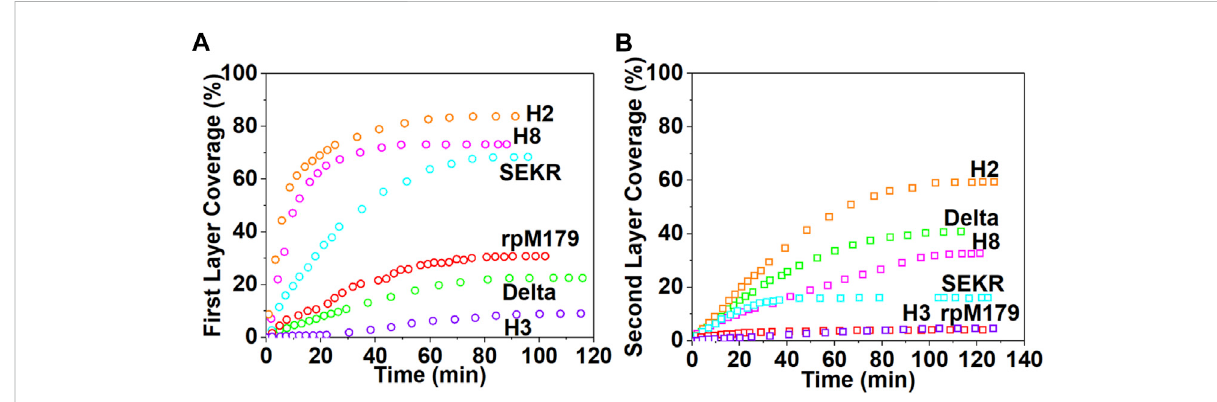
FIGURE 3 The kinetics of protein adsorption determined from the areal coverage of oligomer adsorbates obtained from AFM data for (A) the fi rst layer of adsorption from solutions at 15.6 μ g/ml and (B) the second layer of adsorption from solutions at 125 μ g/ml. The data for rpM179 is from Tao et al., 2019.